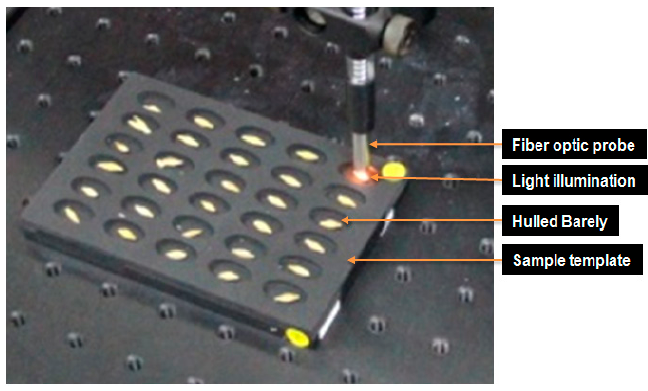
Figure 4. Probe and light illumination in NIR reflectance spectrum acquisition for hulled barley. Reflectance spectral data obtained from hulled barley samples require calibration due to